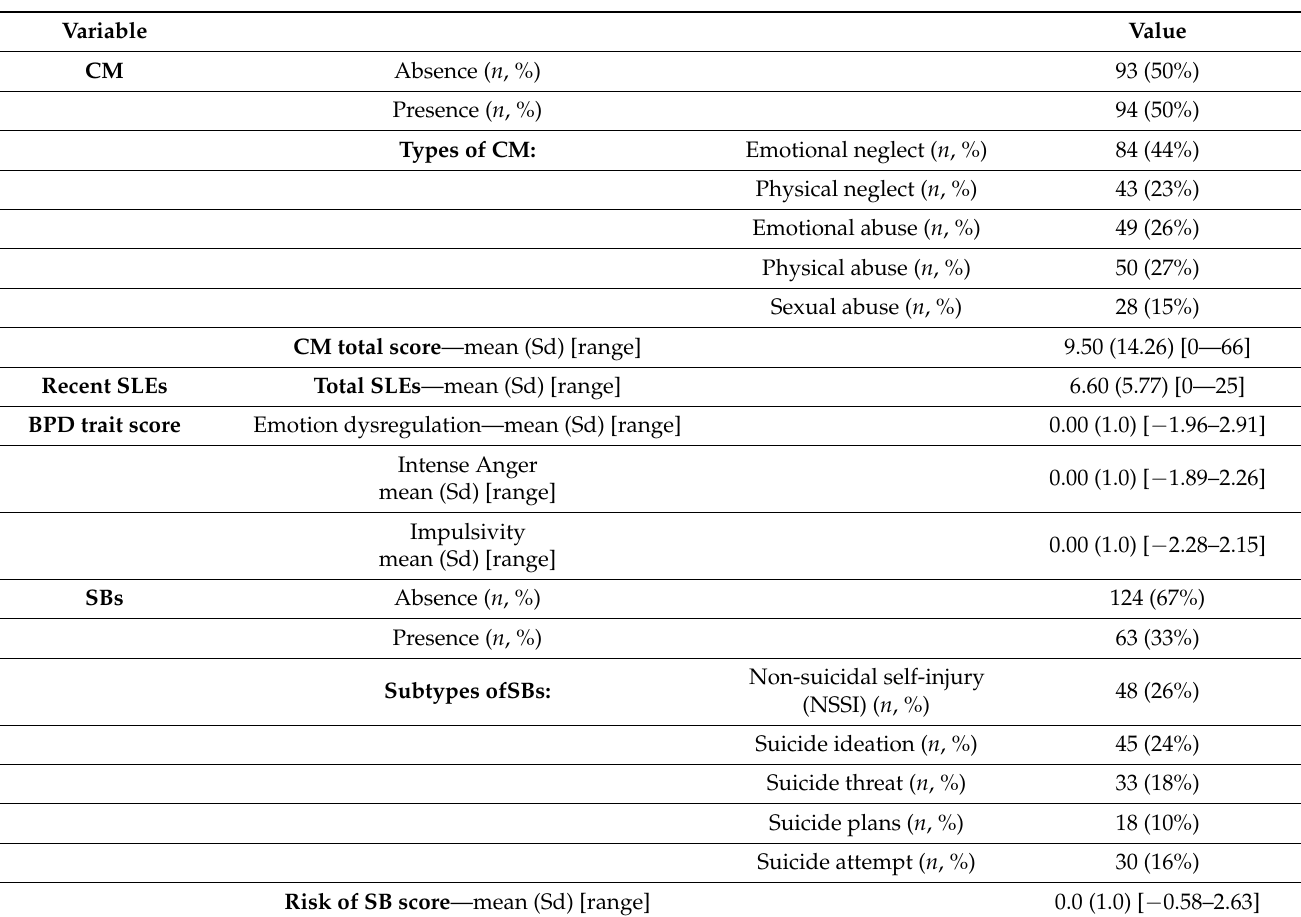
Table 3. Main variables